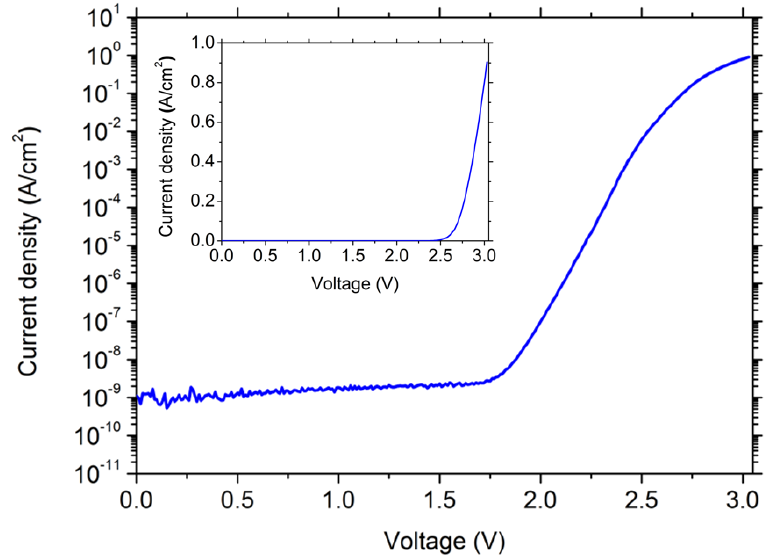
Figure 2. Current density vs. voltage characteristic at RT in forward bias from 0 to 3 V, in dark